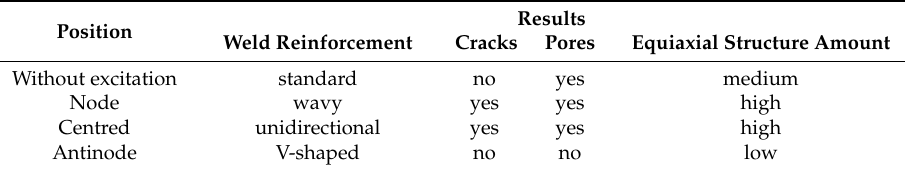
Table 4. E ff ects of di ff erent ultrasonic excitation positions. Results Position Weld Reinforcement Cracks Pores Equiaxial Structure Amount Without excitation standard no yes medium Node wavy yes yes high Centred unidirectional V-shaped